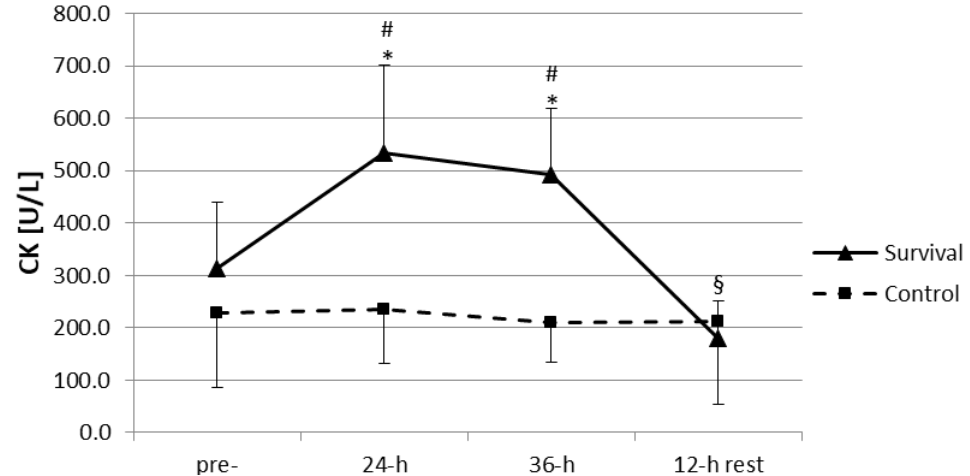
Figure 3. Changes in plasma activity of creatine kinase (CK) (U/L) in control group ( n = 11) and survival group ( n = 12). Values are means ± SD. Main effects: time ( p = 0.000001); group ( p = 0.005); group × time ( p = 0.000001); * significant difference ( p < 0.05) as compared to pre-training (within same group); § significant difference ( p < 0.05) as compared to pre-training, 24-h, and 36-h (within same